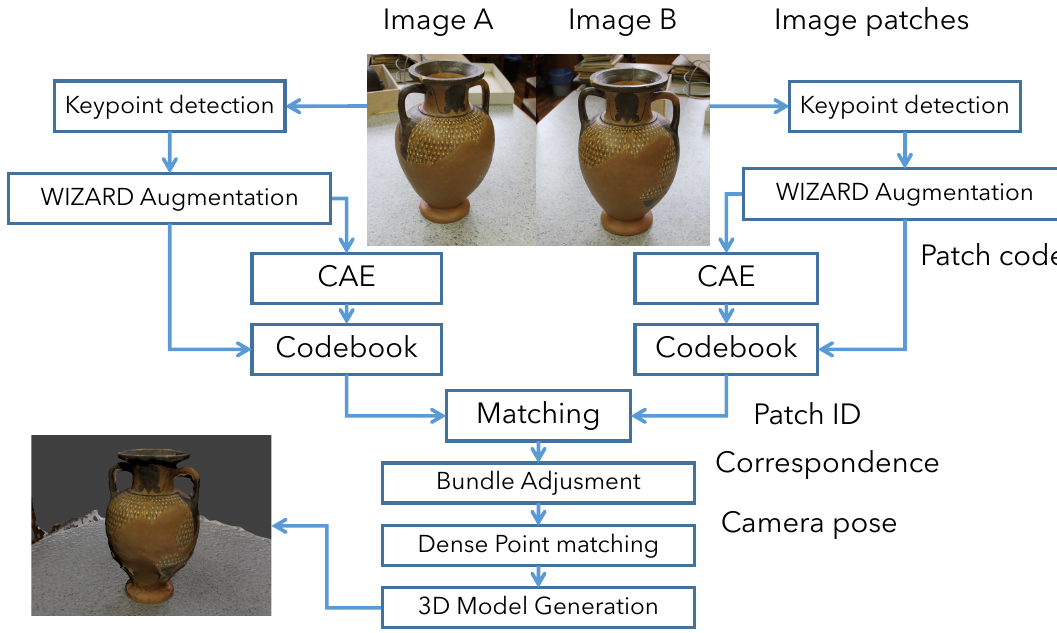
Figure 1. A 3D model generation